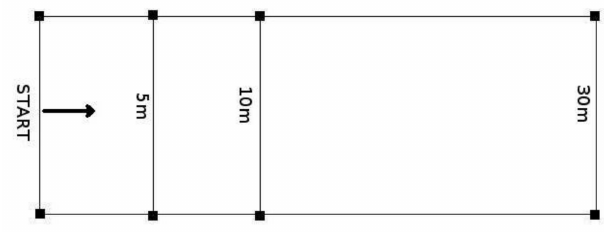
Figure 1. The layout of the of 30-m dash sprint.